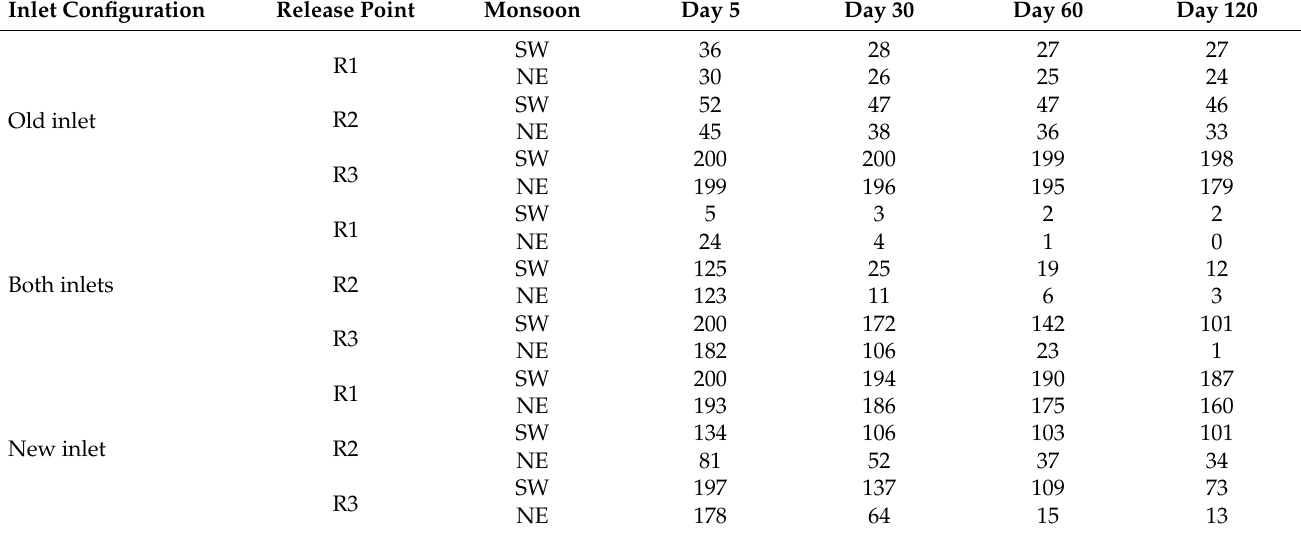
Figure 10. Spatial distributions of the current speed and trajectories for particles released at R1, R2 and R3 (please refer Figure 2 for initial release locations) on ( a ) Day 5, ( b ) Day 30, ( c ) Day 60 and ( d ) Day 120 during the northeast monsoon for new inlet configuration. Table 3. The number of remaining particles released at R1, R2 and R3 on Days 5, 30, 60 and 120 of simulation. ‘SW’ denotes the southwest and